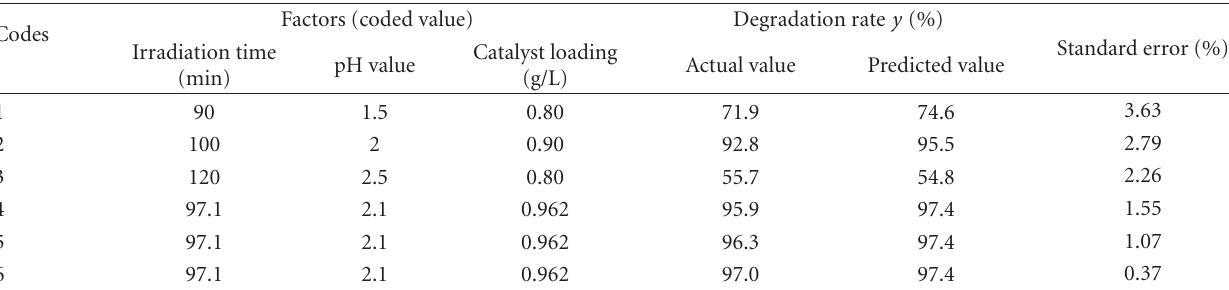
Figure 7: The response surface plot and the corresponding contour plot showing the e ff ects of pH and catalyst loading on naphthalene degradation rate. Table 4: Confirm analyses for the model on naphthalene